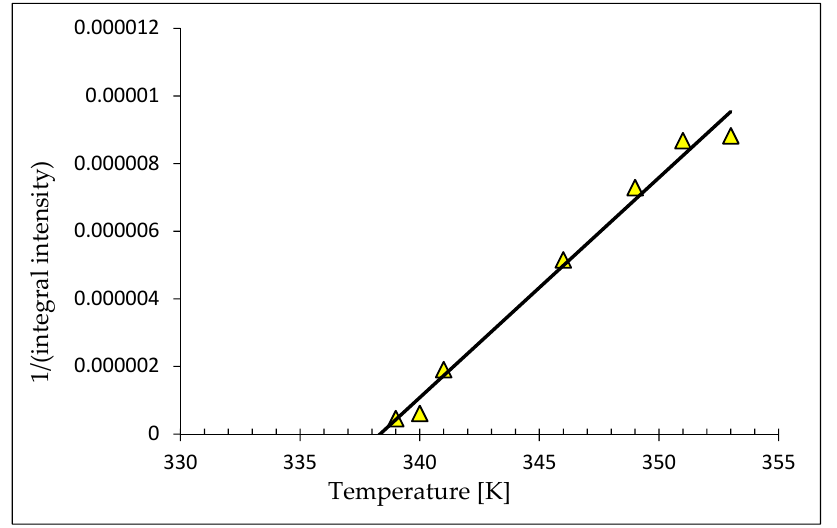
Figure 12. Temperature dependence of the 1/(integral intensity) of the sample 4p.